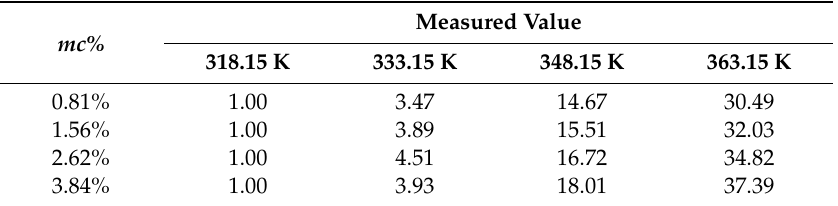
Table 1. Calculation results of the time-shift factors at various temperatures.